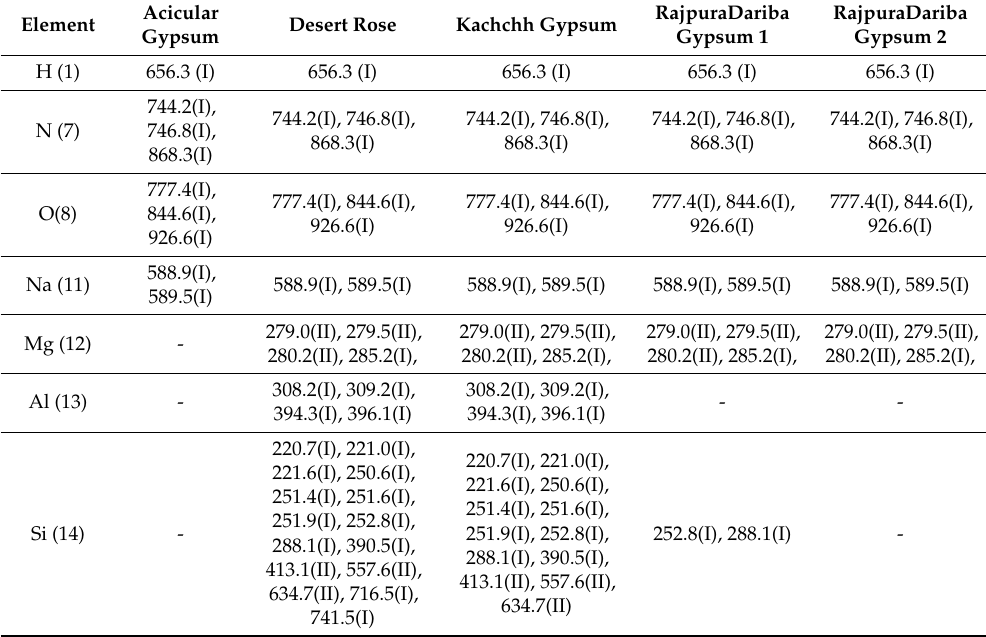
Table 1. Spectral wavelengths of atoms observed in laser induced breakdown spectroscopic spectra of di ff erent gypsum samples: Hydrogen, nitrogen, oxygen, sodium, magnesium, aluminum, and silicon.